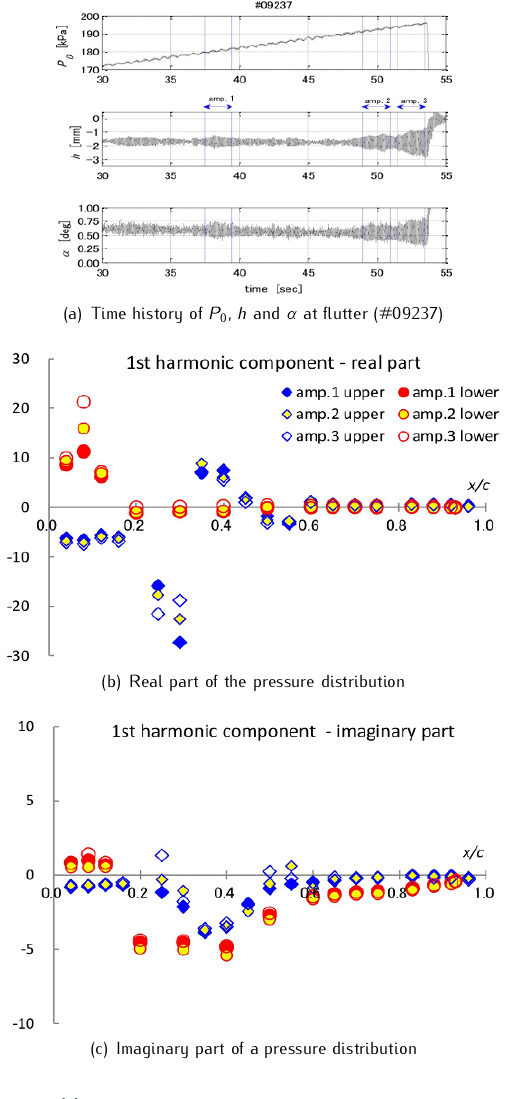
Figure 11. Dependency of pressure distributions on flutter points. pressure in the wind tunnel before the flutter onset. As the amplitude increases, the peak values on both upper and lower surfaces changes. The point with the maximum amplitude for each flutter is selected for the following discussion of unsteady pressure distributions. and analysis are shown in Figures 12–17. (cid:78) (cid:72) Symbols and indicate the experimental results on the upper and the lower surfaces, respectively. Thick lines and thin lines are analytical results on the upper and the lower surfaces, respectively. Dotted lines in Figure 12